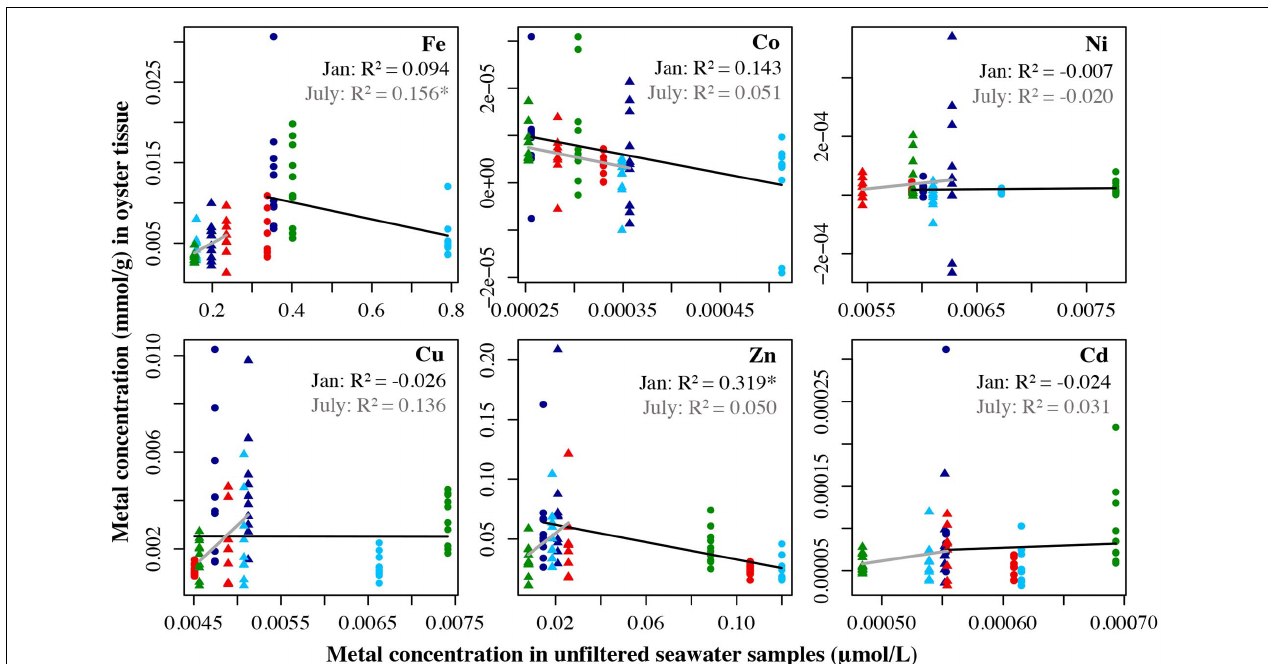
FIGURE 5 | Metal concentration ( µ mol/L) in unfiltered seawater samples from July 2018 and Jan 2019 plotted against the metal concentration the oyster tissue samples (mmol/g) from the four locations collected in July 2019 and Jan 2019. Circles represent the January samples, triangles represent the July samples. Dark blue = Carr Inlet 20 m, light blue = Carr Inlet 5 m, green = Point Wells 5 m, and red = Dabob Bay 5 m. Linear regression was used to assess the relationship between the two variables for Jan (black line) and July (gray line) separately. Asterisk indicates the adjusted the R 2 value is significant after Bonferroni correction (alpha of